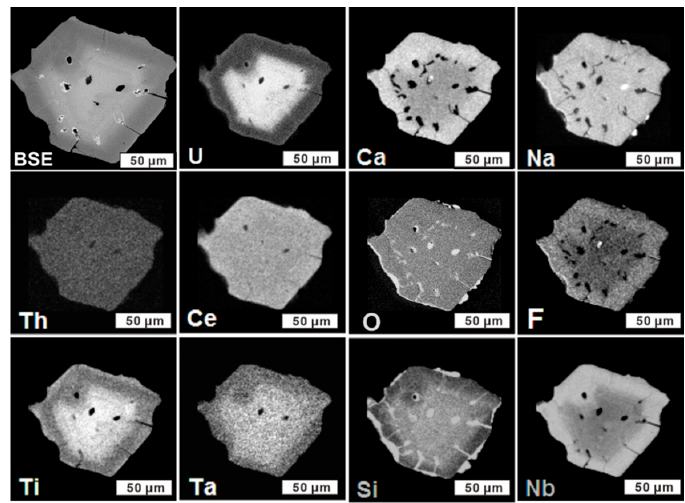
Figure 13. Backscattered electron images and elemental maps of the zoned oxycalciopyrochlore formed in the primary magmatic crystallized stage in the Huili area.